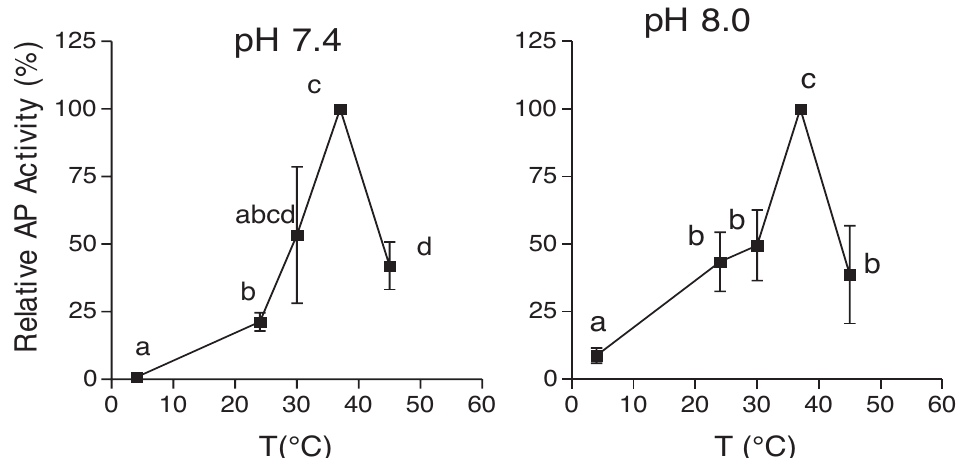
and hyperregulates, respectively (table 1). in crabs acclimated to 35 psu, chela muscle exhibited a low na + -K + atPase activity (27.9 ± 3 nmoles Pi x min -1 x mg prot -1 ). in individuals acclimated to low salinity na + -K + , atPase activity was about 2.3 times higher (Fig. 8; table 2). no differences in residual (Mg 2+ - na + ) atPase activity were found in muscle of indi- viduals acclimated to either 35 or 10 psu (table 2). in individuals acclimated to 10 psu, levamisole- sensitive aP activity at pH 7.4 (548.5 ± 21.5 nmol pnP min -1 mg protein -1 ) was higher than the activity in crabs acclimated to 35 psu (449.7 ± 34.8 nmol pnP min -1 mg protein -1 ; Fig. 8; table 2). levami- sole-insensitive aP activity was not affected by ac- climation of crabs to 10 psu (table 2).